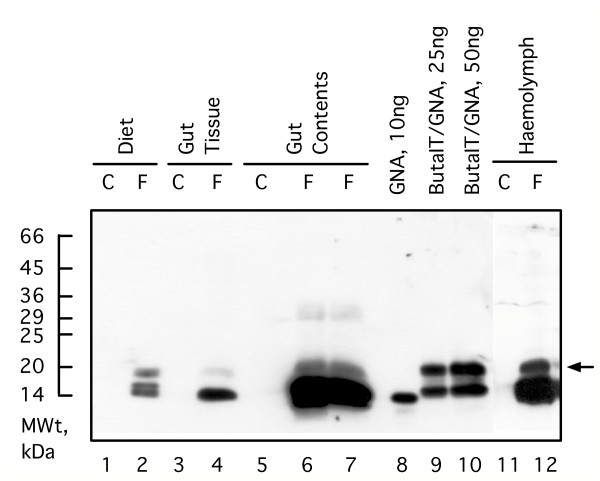
Presence of ButaIT/GNA fusion protein in gut and haemolymph of L. oleracea larvae following feeding. Samples were taken from third stadium L. oleracea larvae fed for 12 days on control diet (C), or diet containing ButaIT/GNA (F; 4.5 mg/5 g diet). Proteins were resolved by 15 % acrylamide SDS-PAGE gel, electroblotted onto nitrocellulose, and probed with anti-GNA antibodies. Loading is as follows: lanes 1, 3, 5 and 11 are control diet, gut tissue, gut contents and haemolymph respectively; lanes 2, 4, 6, 7 and 12 are ButaIT/GNA diet, gut, gut contents and haemolymph; lane 8 is a GNA standard (10 ng); lanes 9 & 10 are ButaIT/GNA standards of 25 and 50 ng, respectively. Loading, as estimated by Bradford assay, was 40 μg total protein for all gut and haemolymph samples.